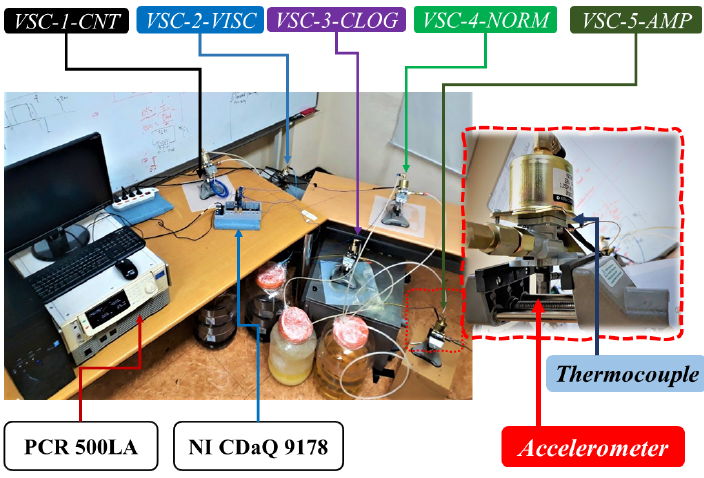
Figure 3. Photo of experimental